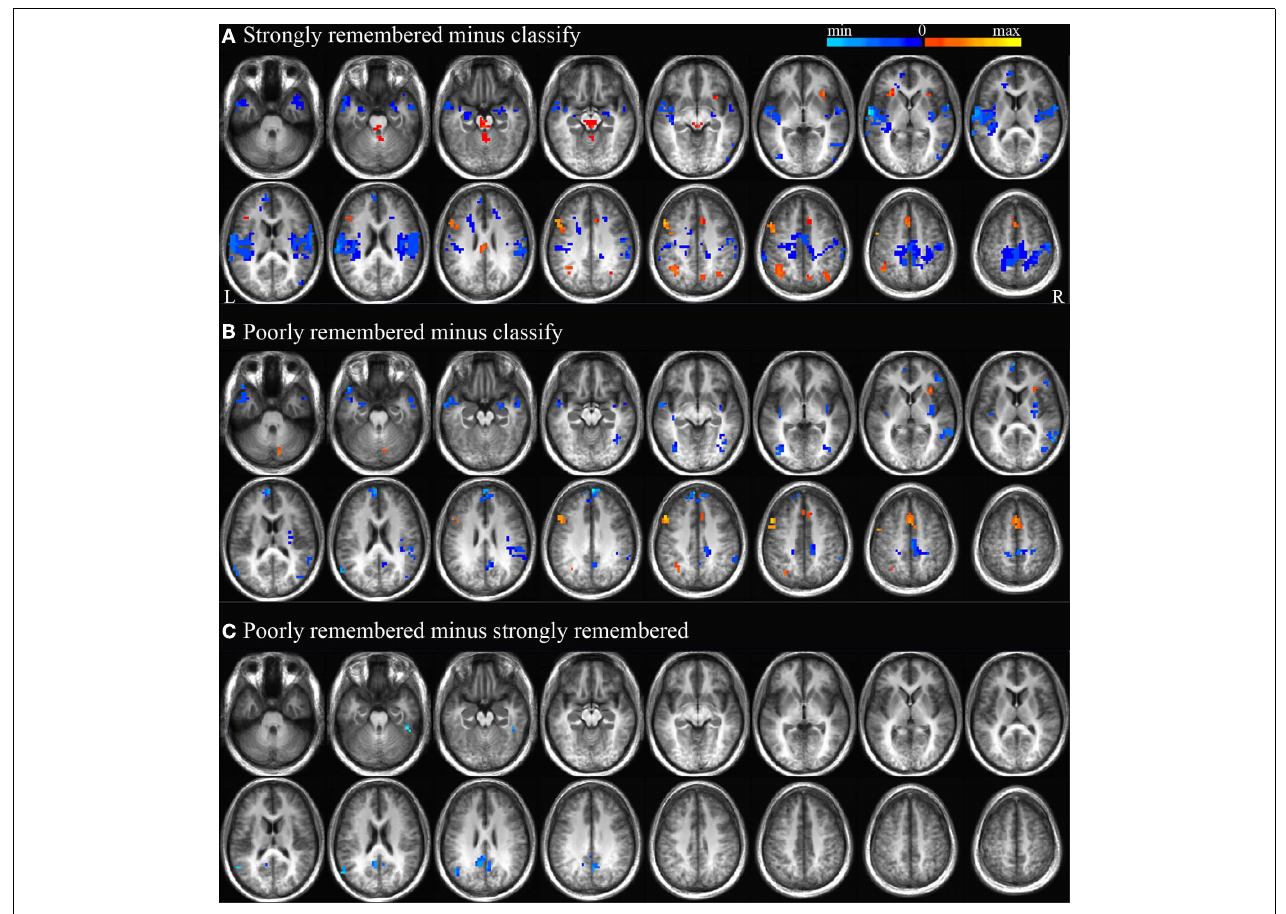
are displayed in warm colors and negative activity differences are displayed in cool colors. Subtraction maps are overlaid on every five axial slices of an average anatomical image of all subjects. As depicted in Figure 5A , these activation differences are expected to represent processing related to search, retrieval and post-retrieval processing (A,C) , or search only (B)